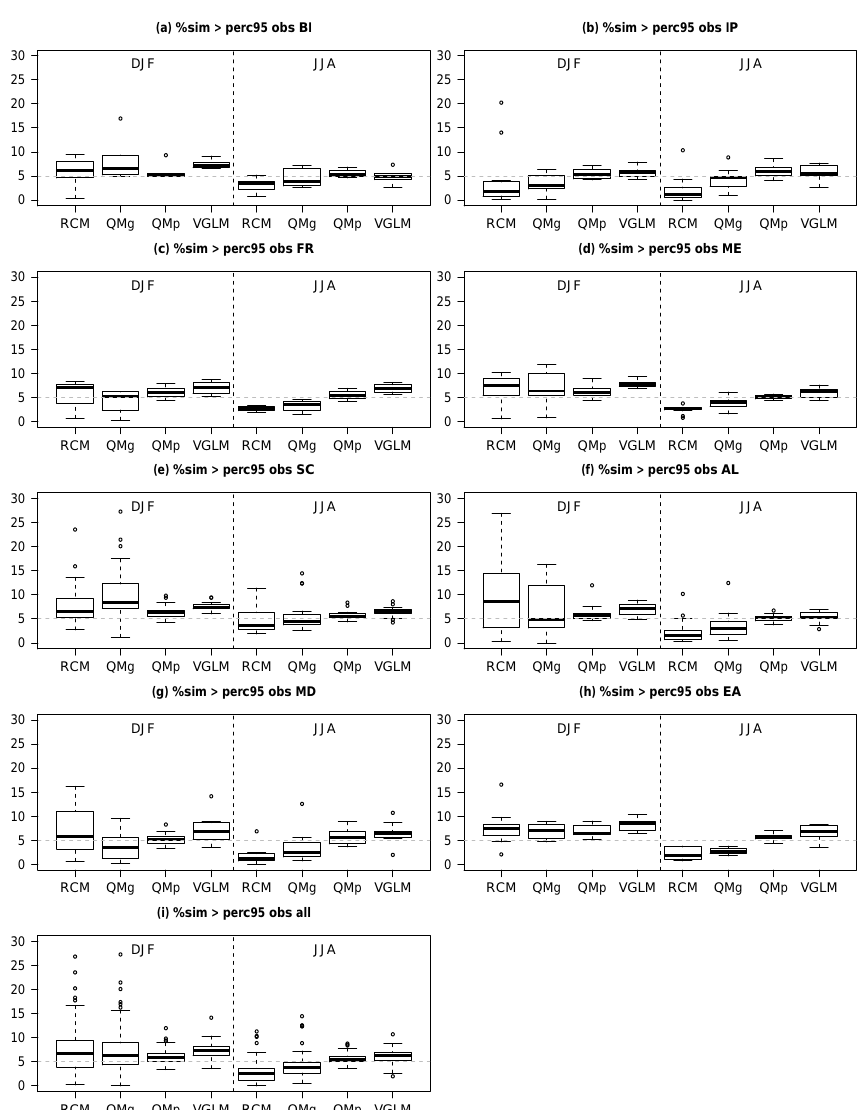
Figure 12. As in Fig. 11, but for percentage of simulated wet days exceeding the observed 95th percentile (%sim > perc95 obs ). Outlier out of range in (g, i) QM grid DJF: